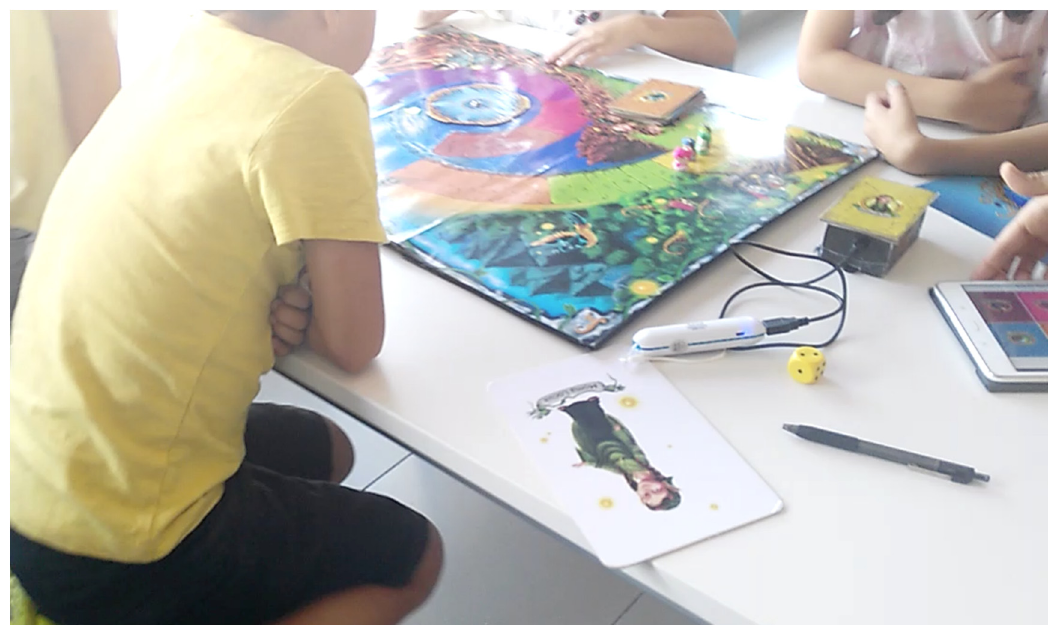
Figure 9. Playing PHONOMAGIC at the ASPAS Institute in Mallorca, Spain.